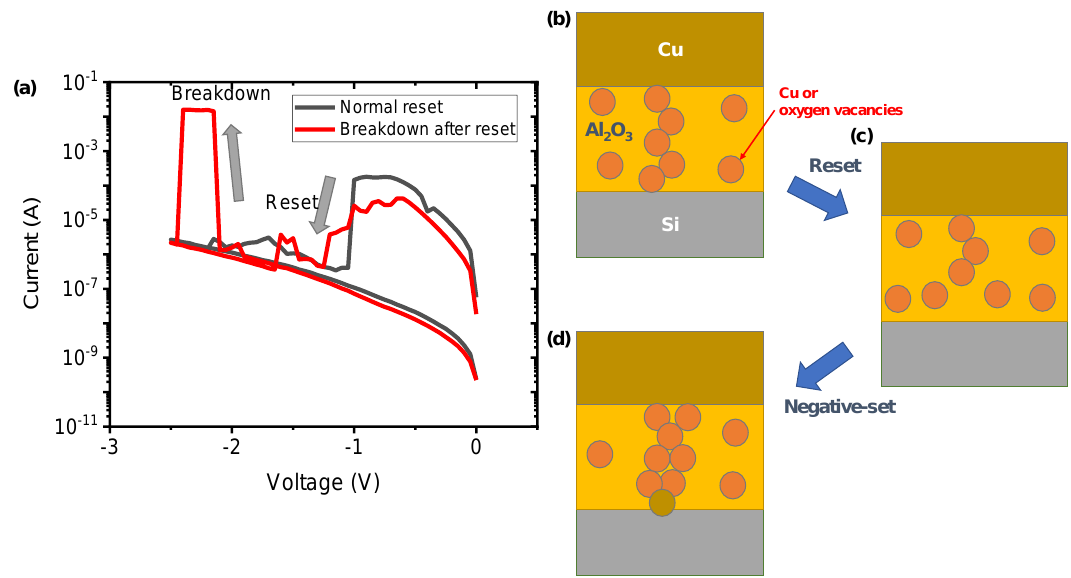
Figure 4. ( a ) I–V curve of negative-set behavior. Illustration of filament for ( b ) LRS, ( c ) high-resistance state (HRS) by reset, and ( d ) set stuck by negative-set behavior.